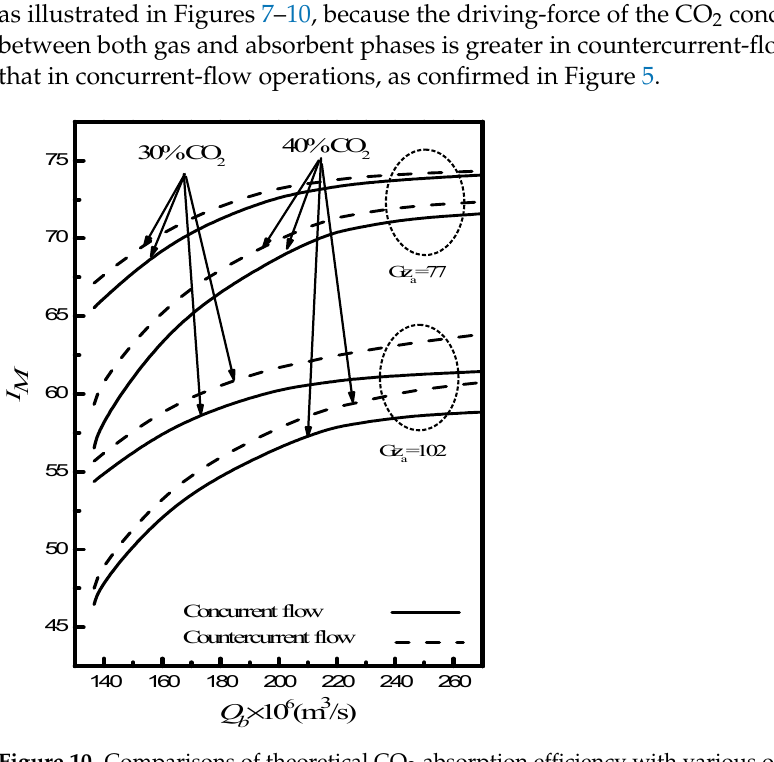
Figure 10. Comparisons of theoretical CO 2 absorption efficiency with various operating parameters.